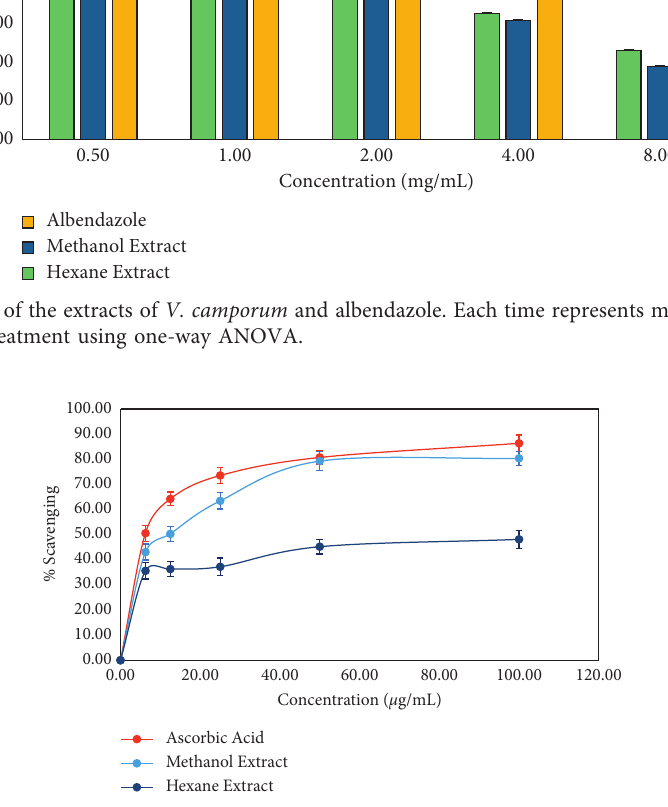
Figure 4: Comparative DPPH radical scavenging activity of the extracts of V. camporum and ascorbic